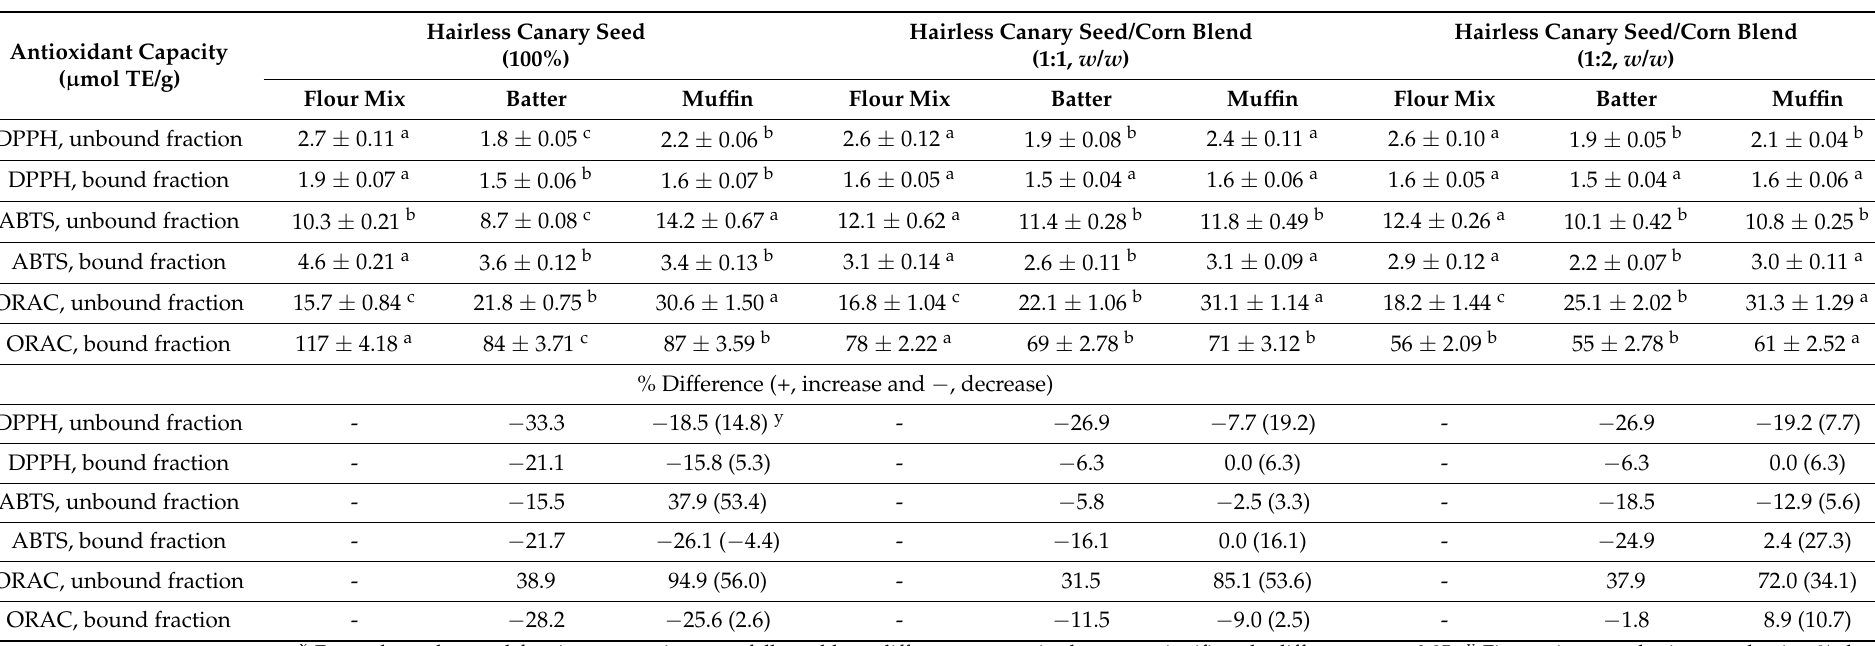
Table 5. Antioxidant properties of unbound and bound phenolic extracts of dry flour mix, batter, and fresh muffin products and their influence by baking process x . Antioxidant